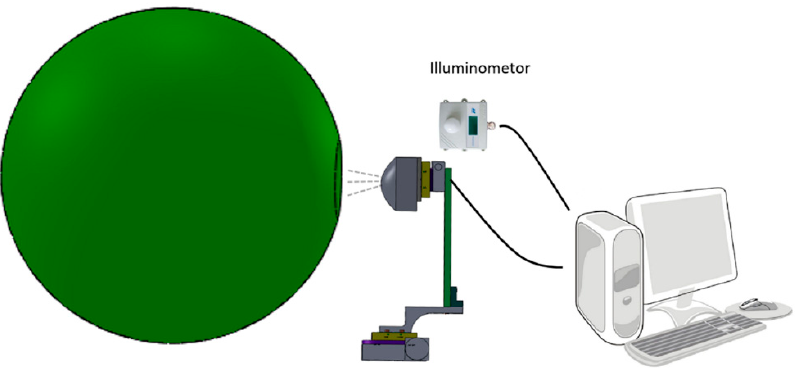
Figure 2. Photometric calibration with an integrating sphere.